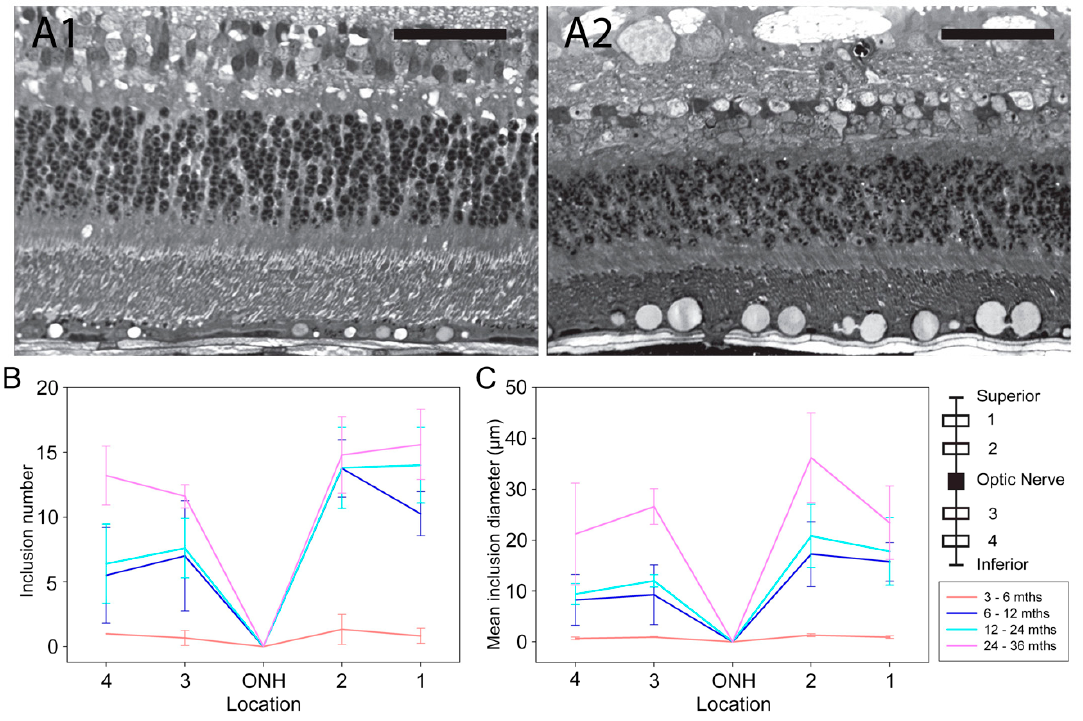
Figure 7. RPE inclusions increase in size and number with age. ( A ). Plastic sections showing RPE inclusions in Rpe65- deficient dogs at 3 ( A1 ), and 36 months of age ( A2 ). (Scale bars = 50 µm.) ( B ). Changes in the mean number of RPE inclusions with age (number per 200 µm). ( C ). Changes in mean diameter of inclusions (micrometers). Dogs are grouped as follows: 3–6 months, n = 3 eyes; 6–12 months, n = 4 eyes; 12–24 months, n = 5 eyes; 24–36 months, n = 5 eyes. Inset shows the sampling positions.